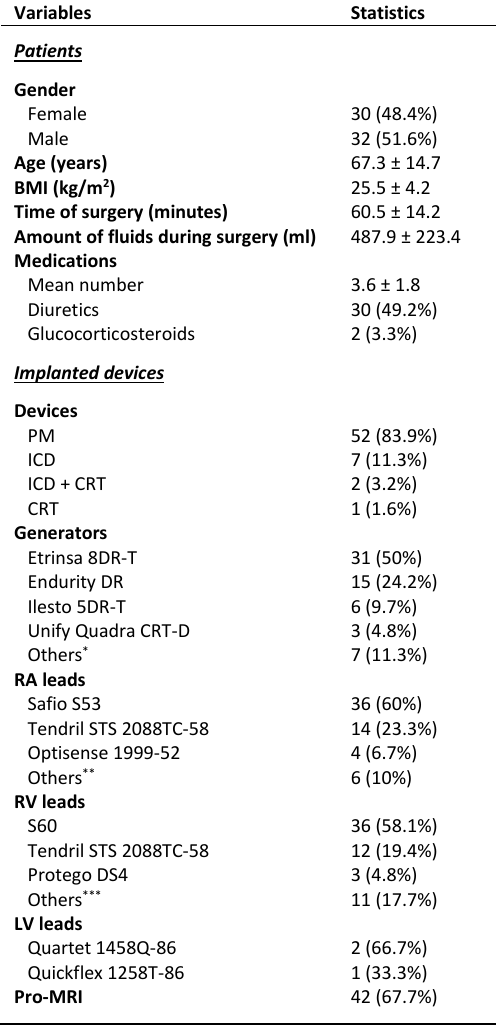
Table1: Characteristics of the implanted